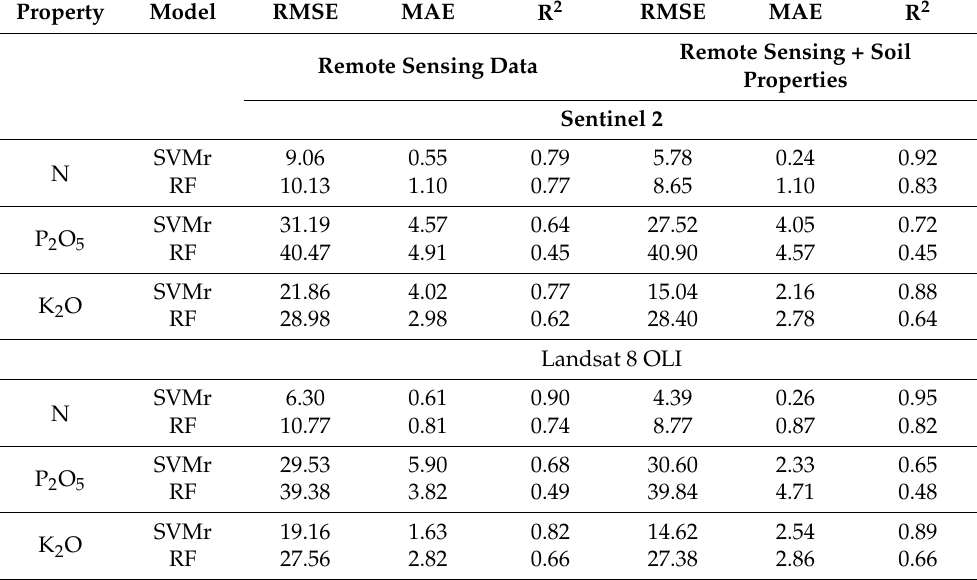
Table 3. Estimation of the accuracy of models of available forms of nitrogen, phosphorus and potassium based on remote sensing data and remote sensing with soil properties (SOC, Silt,